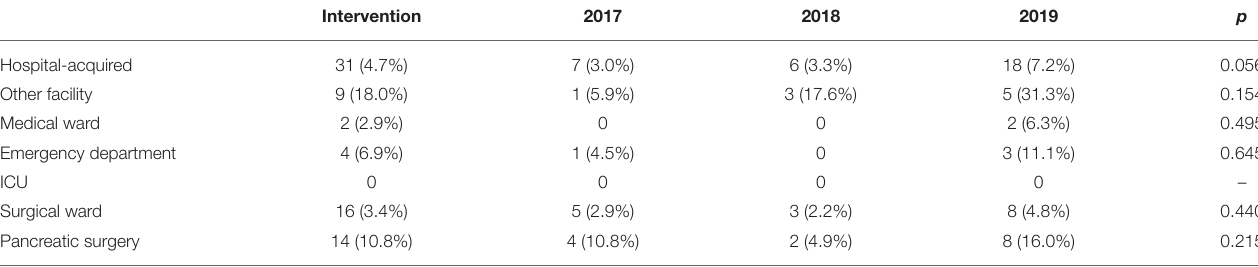
TABLE 5 | The sources of CRKP during the intervention period.